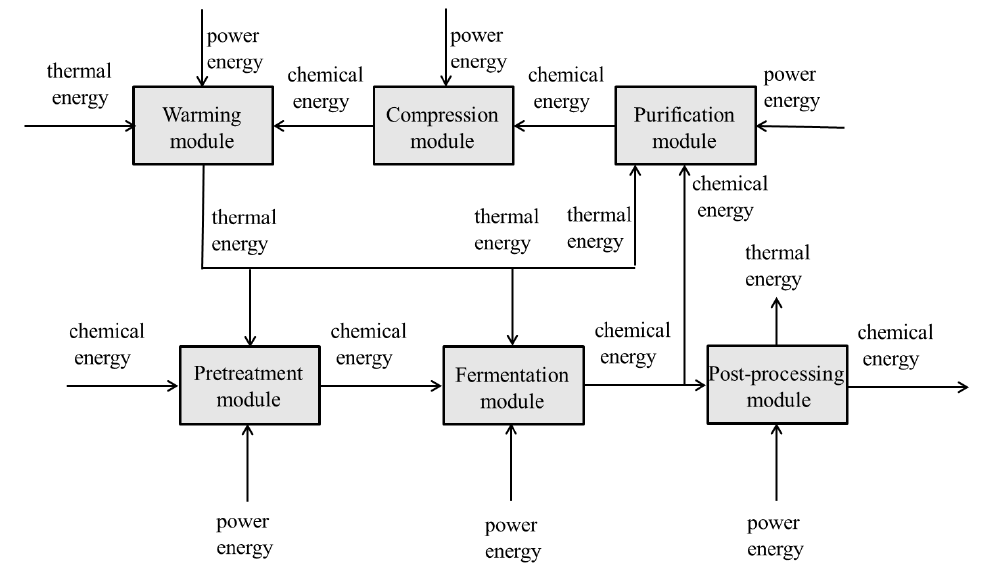
Figure 2. Energy balance of the system.